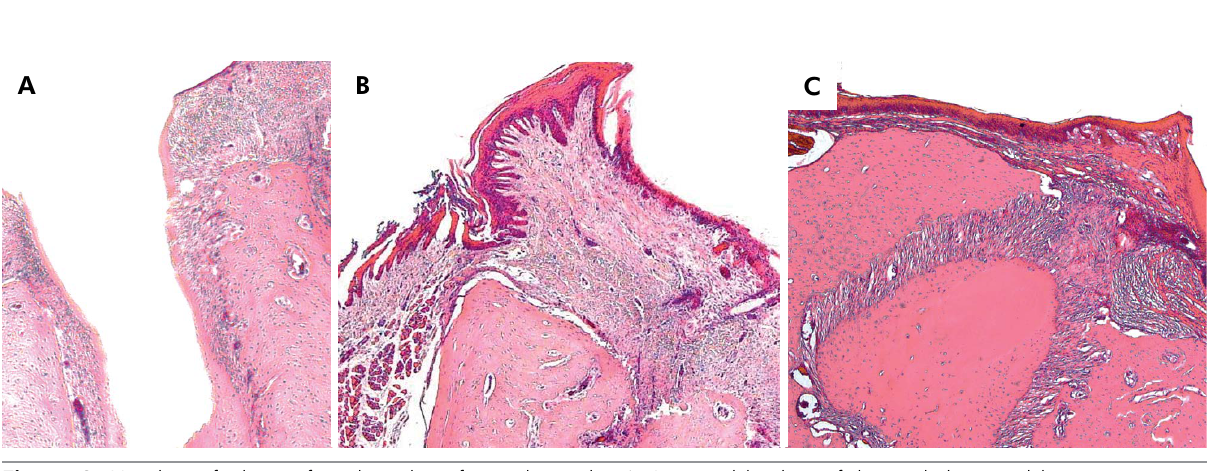
Bone density (greyscale levels) Mean values / SD